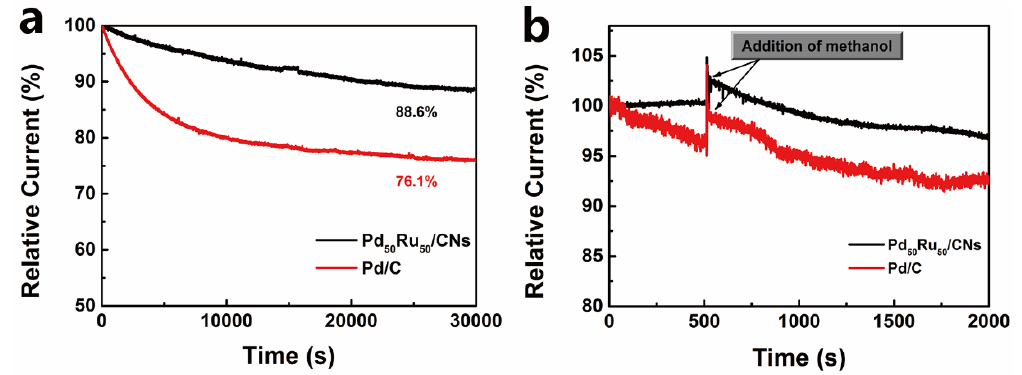
Figure 4. ( a ) Chronoamperometric curves of Pd 50 Ru 50 /CNs and Pd/C catalysts at +0.5 V for 30,000 s. ( b ) Chronoamperometric curves of Pd 50 Ru 50 /CNs and Pd/C at +0.5 V before and after the addition of methanol.